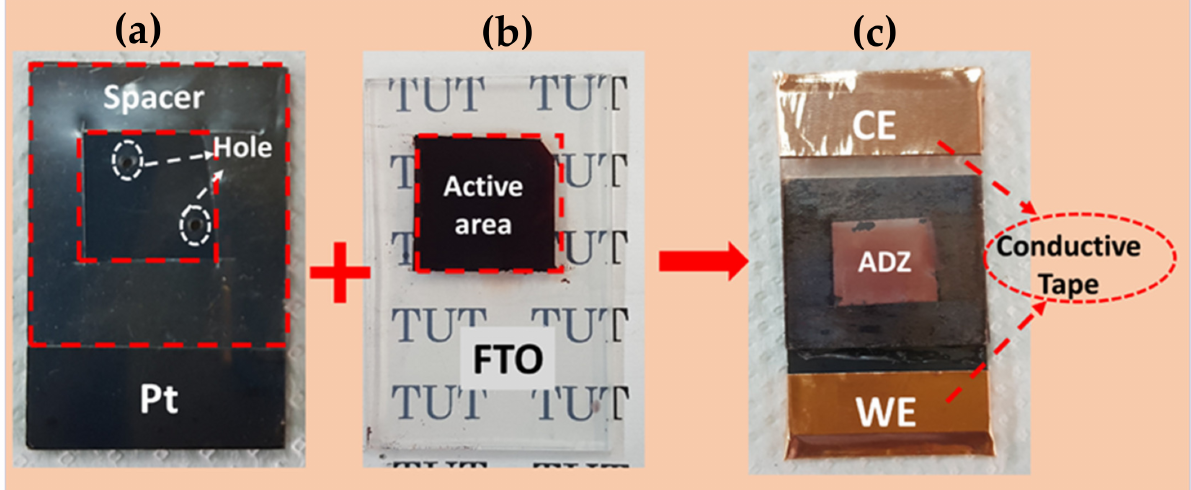
Figure 2. Photographs showing the ( a ) Pt counter electrode (CE), ( b ) N719-sensitized working electrode (WE) and ( c ) fabricated sandwich-type ZnO film based